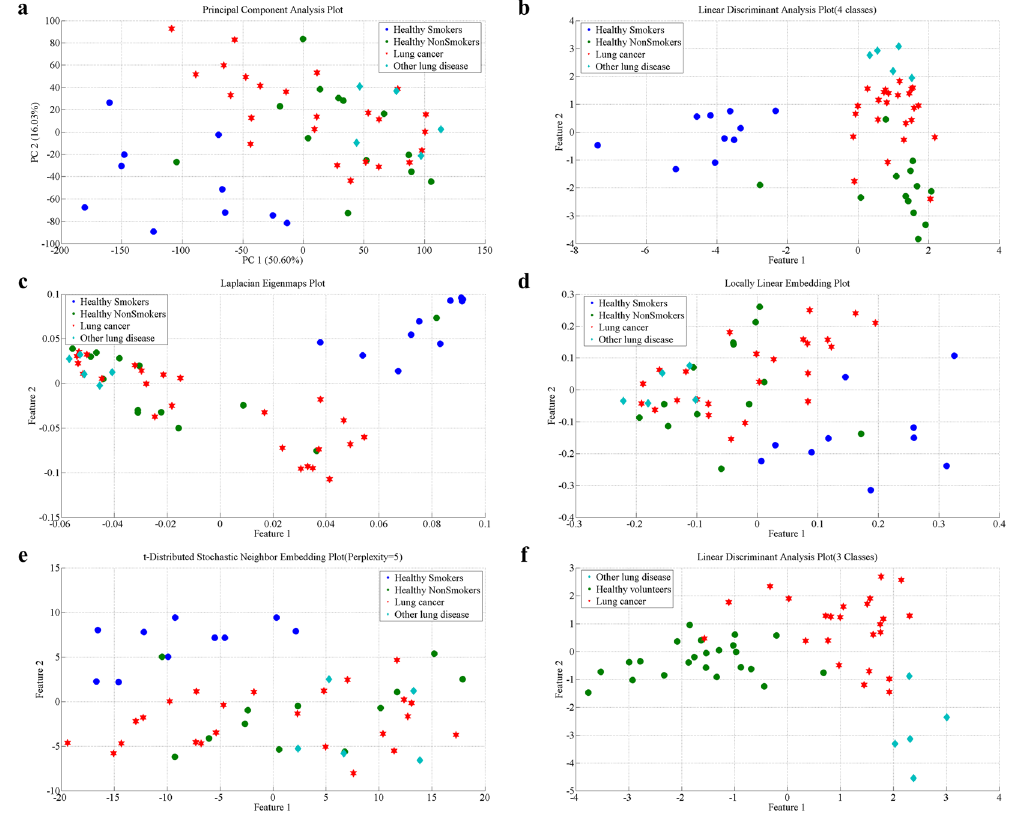
Figure 4. Mapping results of 5 algorithms (2D). ( a ) Represents the 2D mapping plot of PCA, ( b ) is the 2D mapping result of LDA with 4 classes of labels, c is the 2D mapping plot of LE, ( d ) is the 2D mapping plot of LLE, ( e ) is the 2D mapping result of tSNE, and ( f ) is the 2D mapping results of LDA with 3 classes of labels. Green dots represent samples from healthy non-smokers, blue dots represent samples from healthy smokers, red hexagrams represent samples from lung cancer patients, and light blue diamonds represent other disease